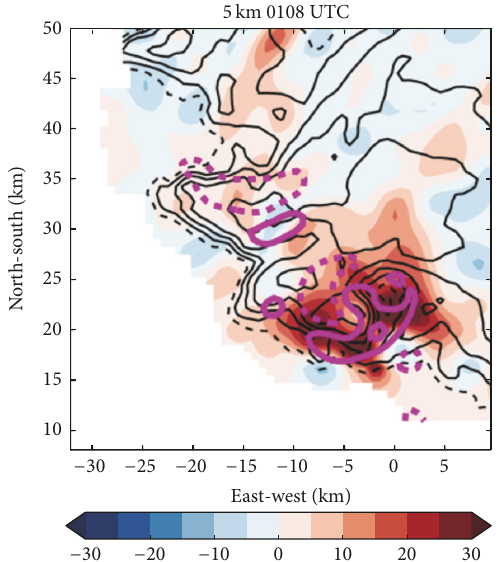
Figure 10: Horizontal cross-sections at 5km altitude for the 0108 UTC analysis of vertical velocity (in m s −1 , according to the color scale), radar reflectivity greater than 20 dBZ (contoured every 10dB with 20 dBZ dashed and higher values solid). Vertical vorticity maxima are annotated in magenta at − 5 (dashed), 10, and 30 (solid) ( × 10 −3 s −1